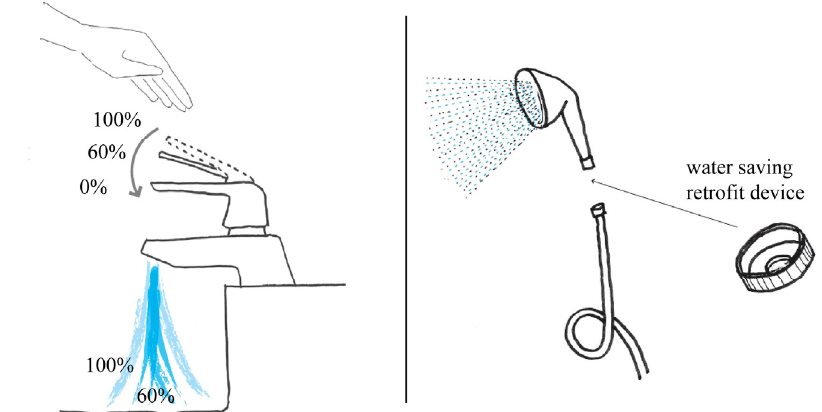
Figure 2. Examples of a water-saving tap with a ‘water brake’ and two flow rates ( left ); and a water-saving showerhead with a retrofitting device, which can be inserted in the fitting between the showerhead and hose ( right